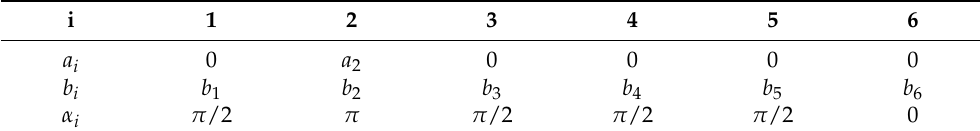
Table 1. DH parameters of the Kinova Gen3